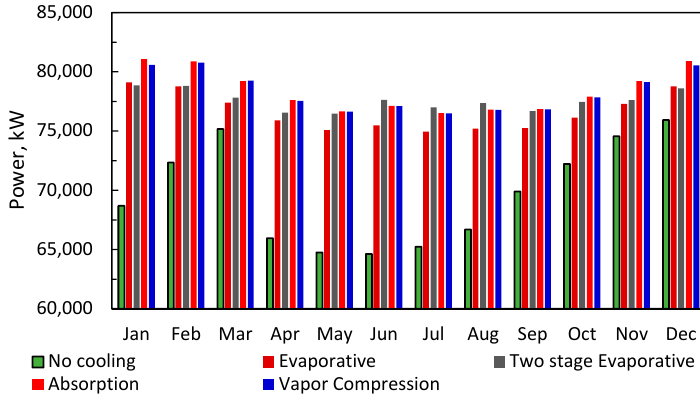
Figure 11. Effect of inlet cooling on turbine power output.